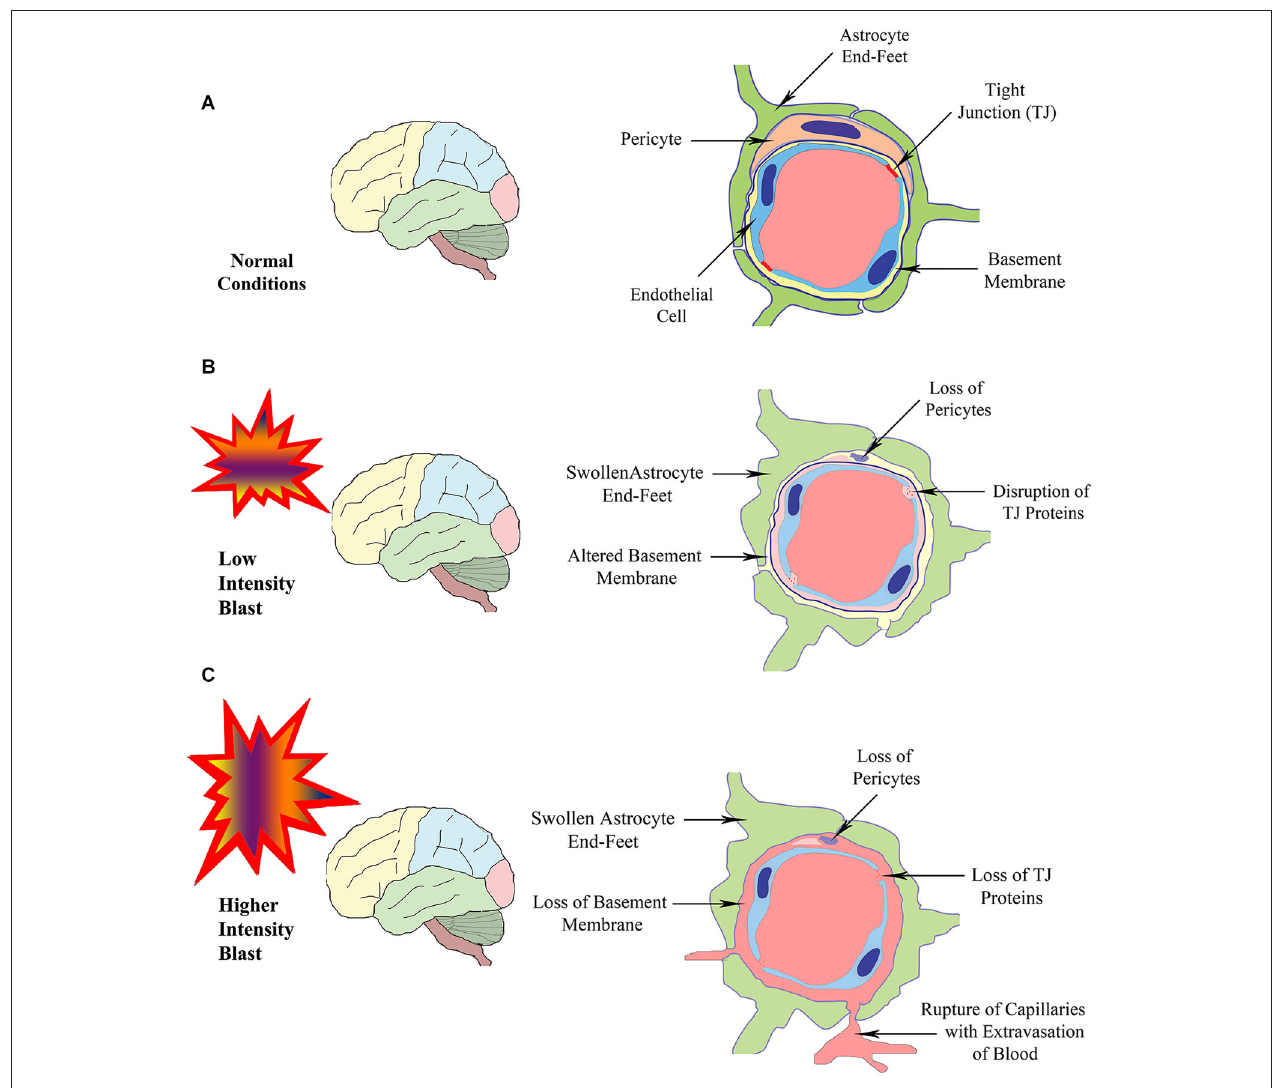
end-feet in brain microvessels (B) . In contrast, exposure to higher intensity BSWs likely cause direct rupture of brain microvessels causing the loss of TJ proteins, BM, pericytes and endothelial cells, swelling of astrocyte end-feet and extravasation of blood (hemorrhage) into perivascular areas (C)